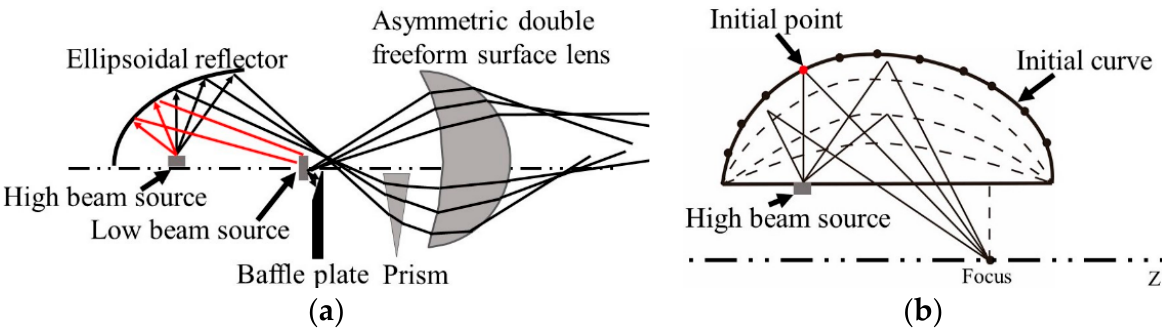
Figure 9. ( a ) Integrated headlamp based on ellipsoidal reflector and ( b ) sketch of the freeform reflector. Due to the symmetry of the reflector, only half of the freeform surface reflector was designed. An initial point is given and the normal vector of the initial point can be obtained according to the vector form of the reflection law, which can be expressed as